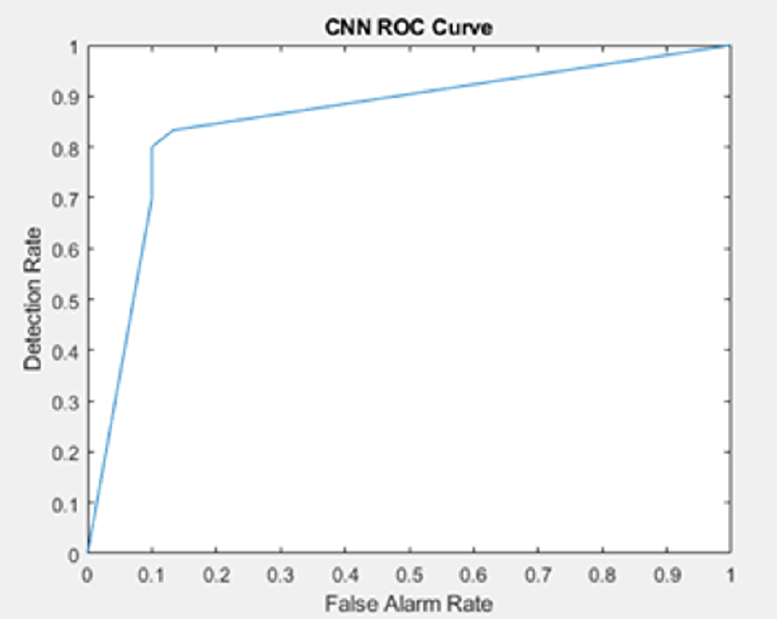
Figure 15. Different scenarios of partial paths receiver operating characteristic (ROC) curve.